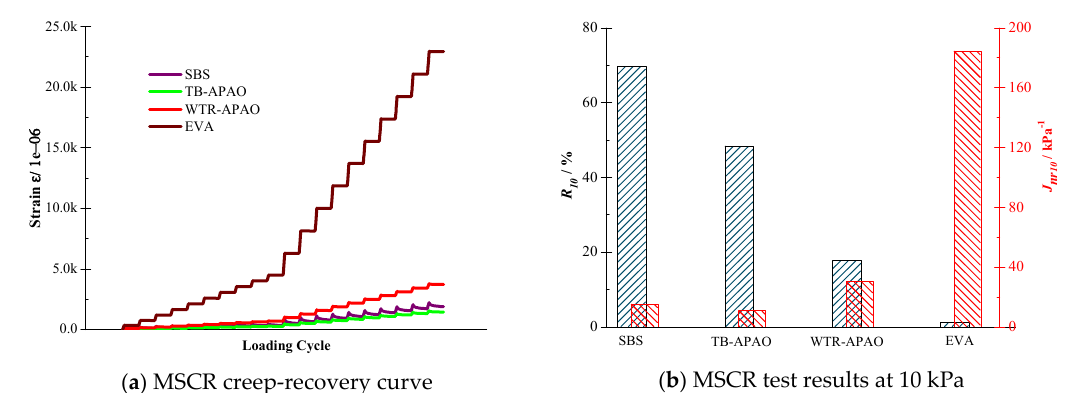
Figure 2. Multiple stress creep recovery (MSCR) test results of the polymer-modified asphalt at 60 °C: ( a ) MSCR creep–recovery curve and ( b ) MSCR test results at 10 kPa.